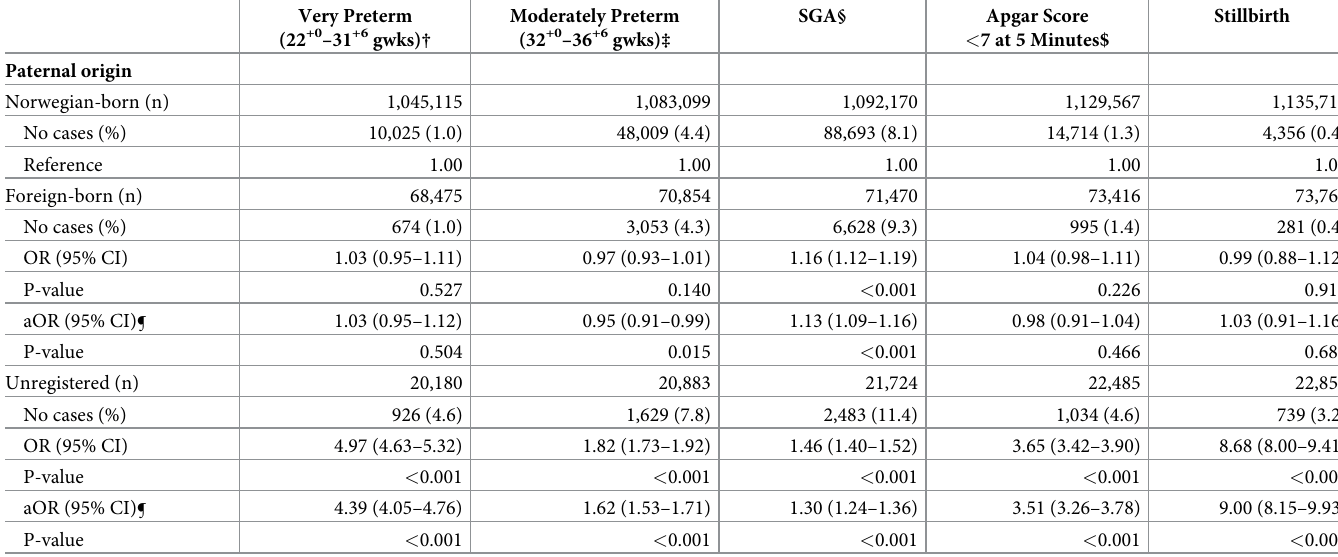
Table 3. Associations between paternal origin and adverse neonatal outcomes in births to Norwegian-born women in Norway